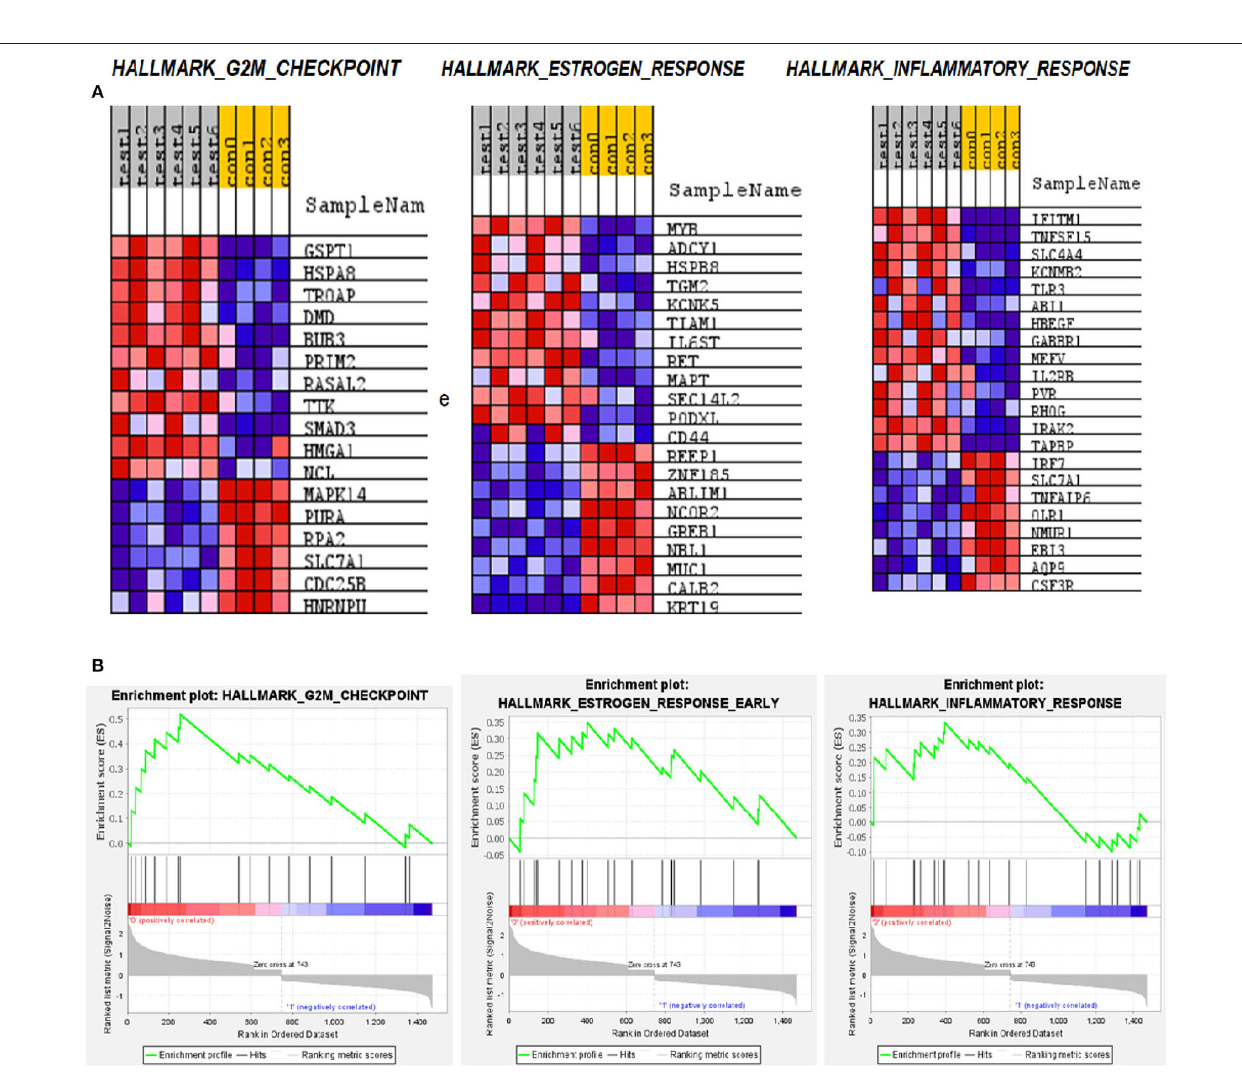
Frontiers in Cardiovascular Medicine |